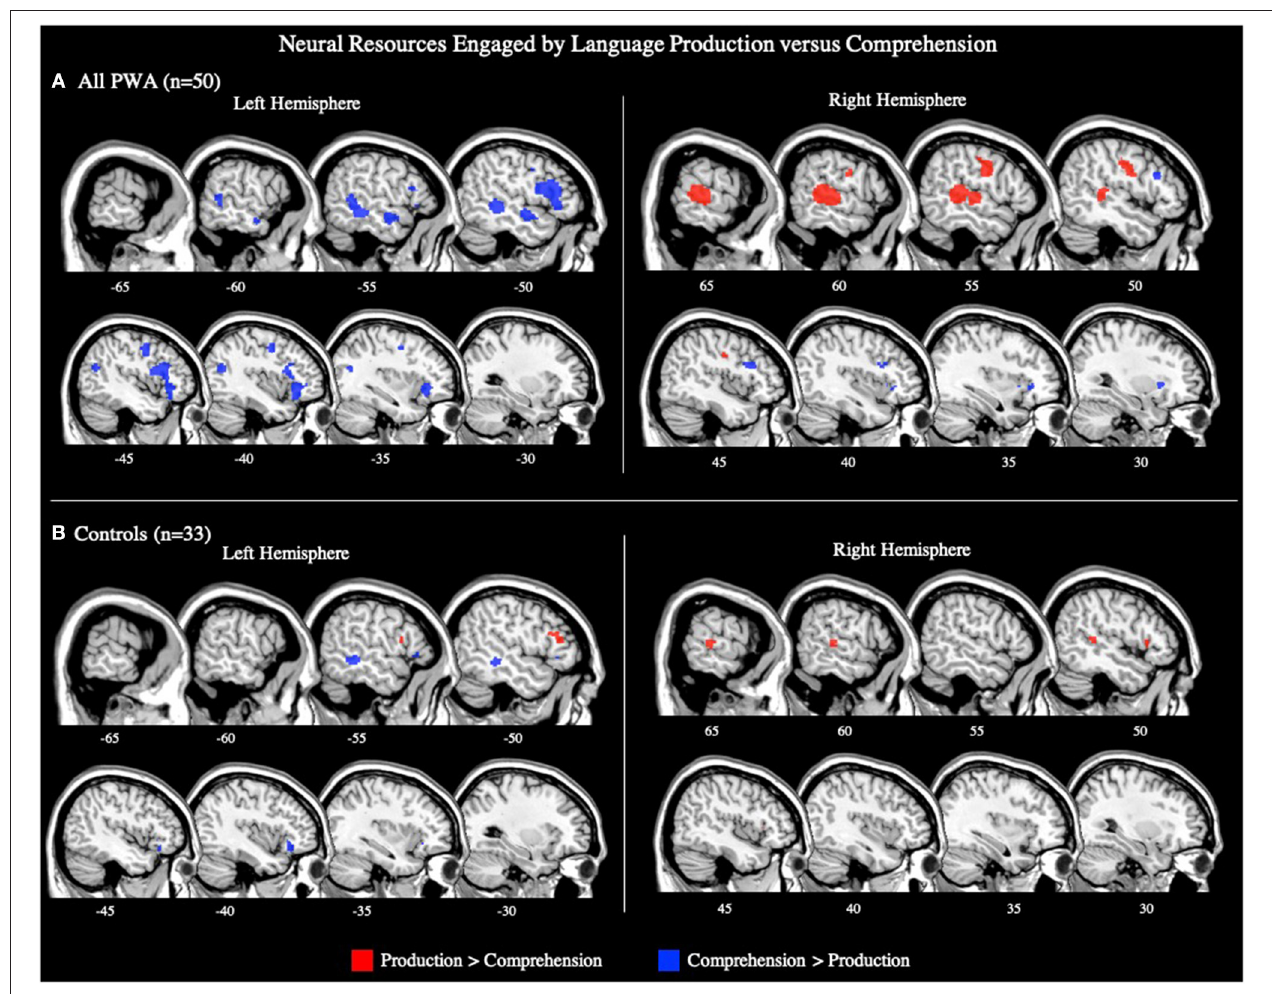
FIGURE 5 | Representative sagittal slices for the production > comprehension and comprehension > production ALEs in (A) PWA and (B) controls ( p = 0.05 uncorrected). Sample size denotes the number of tasks included in the